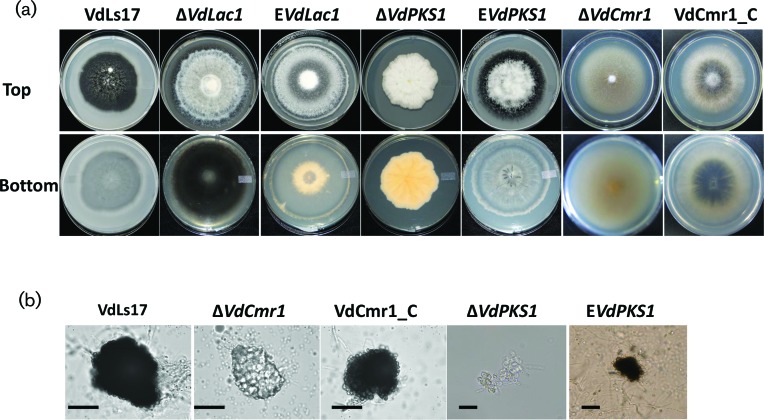
Effect of three gene deletions on melanin production and colony morphology in V. dahliae. (a) Colony appearance of V. dahliae wild-type strain (VdLs17), VdLac1 deletion mutant (ΔVdLac1) and ectopic strain EVdLac1 VdPKS1 deletion mutant (ΔVdPKS1) and ectopic strain (EVdPKS1), and VdCmr1 deletion mutant (ΔVdCmr1), ectopic strain (EVdCmr1) and the ΔVdCmr1-complemented strain (VdCmr1_C) on PDA medium after a 2 week incubation at 25 °C with top and bottom views. (b) Examination of the microsclerotia produced by the wild-type strain VdLs.17 relative to the microsclerotia produced by the corresponding gene knockout strains for VdCmr1 and VdPKS1. The restoration of pigment production is observed for strain VdCmr1_C. Scale bars=20 µm.